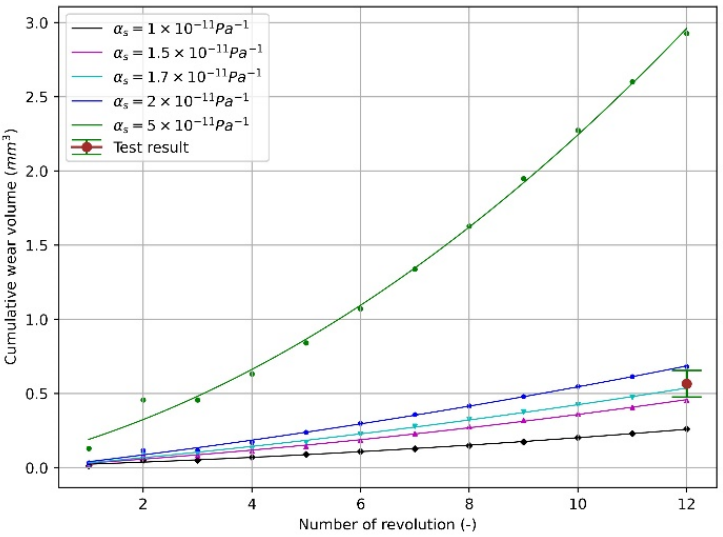
Figure 15. Wear volume as a function of revolution.